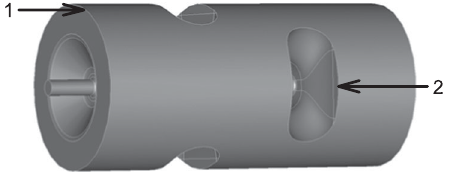
FIG. 31. Cavity with no rounding at (1) the outer conductor edges and (2) the spoke base.